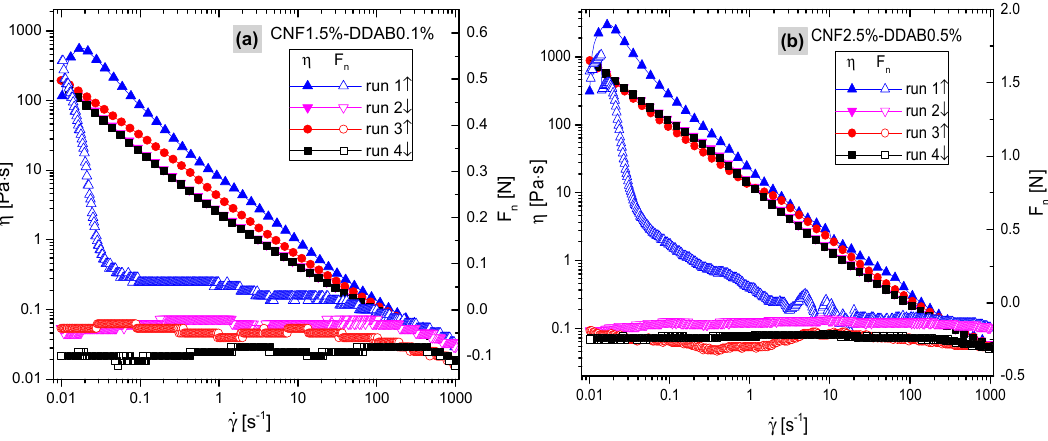
Figure 7. Viscosity (left axis) and normal force (right axis) as the function of shear rate at 1~4 ramps, showing the samples of ( a ) CNF1.5%-DDAB0.1% and ( b ) CNF2.5%-DDAB0.5%, respectively. The normal forces (open symbols) show a sharp decrease for